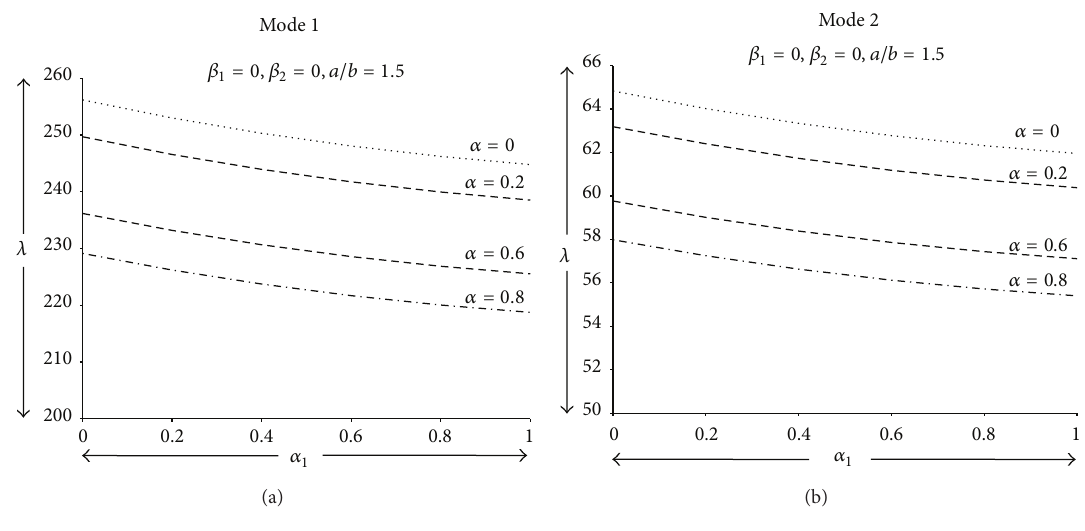
Figure 1: Frequency versus nonhomogeneity